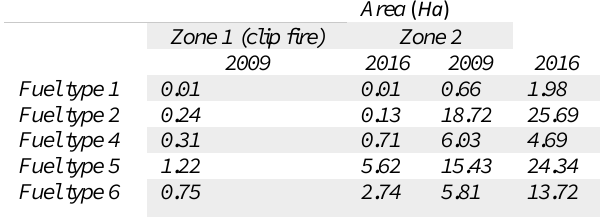
Table 1. Area represent for each fuel type classification.